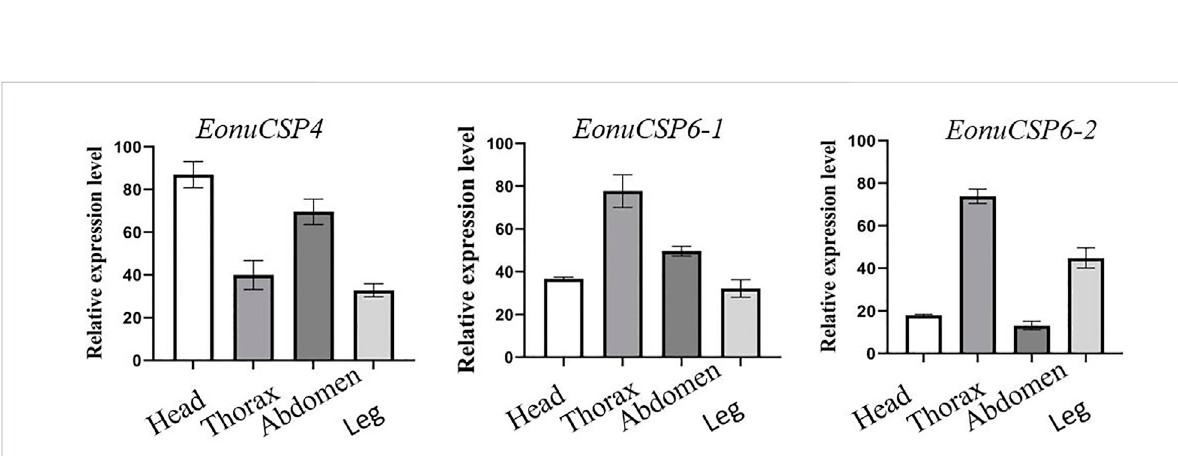
Expression pro fi les of the 3 CSPs in E. onukii. Transcript levels of the CSPs were normalized by β